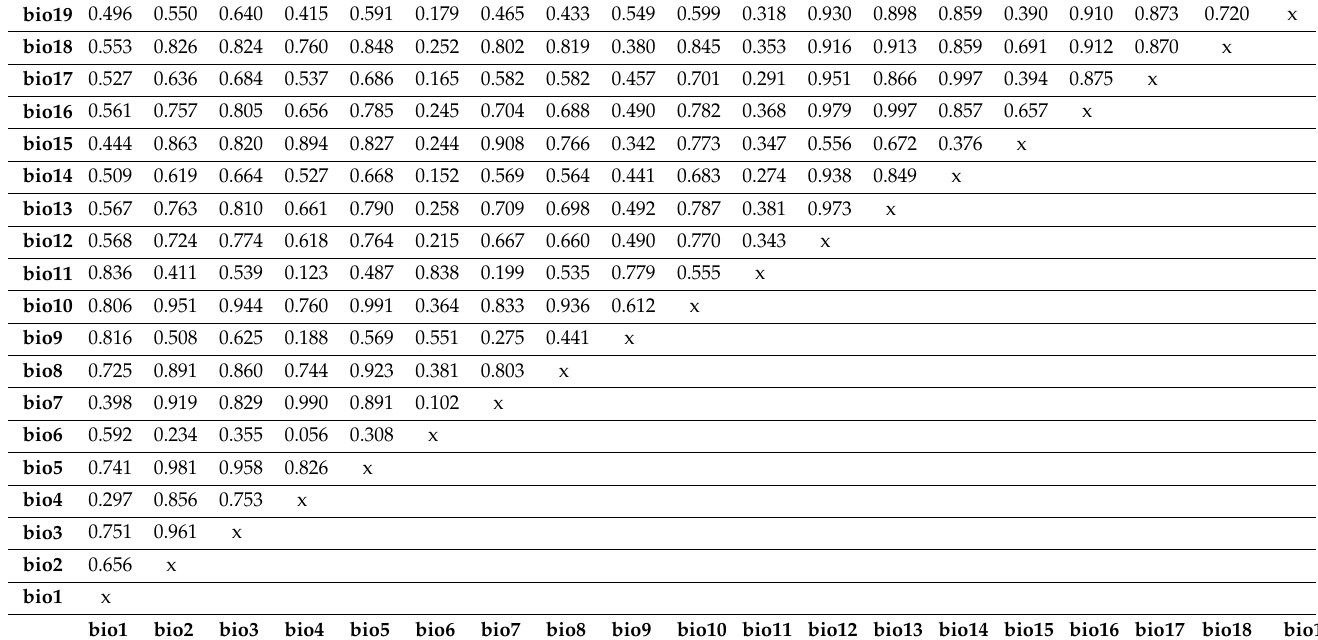
Table 1. Pearson correlation coefficient for 19 bioclimatic